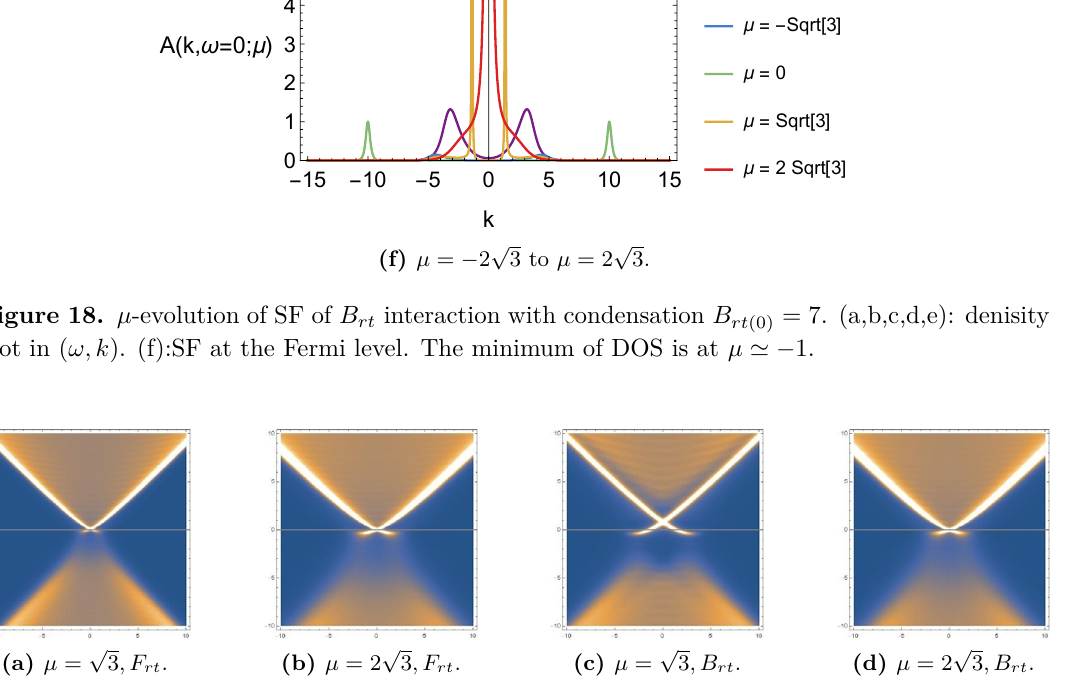
= 7 . Two models are